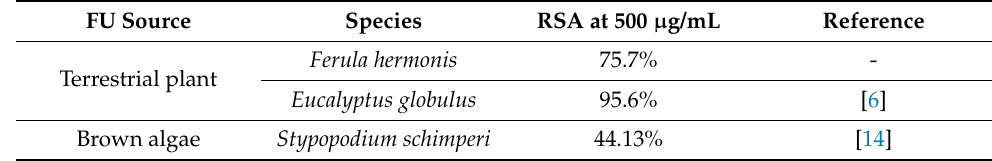
Table 4. Maximum RSA of FU extracted from different species at 500 µ g/mL.